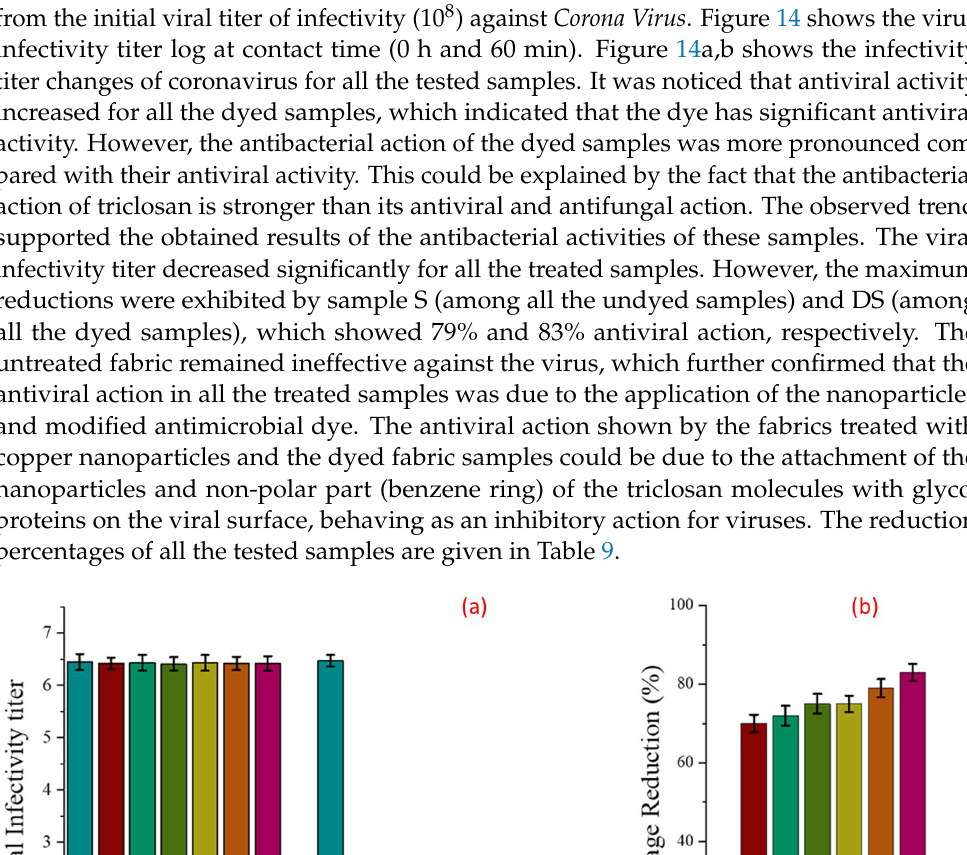
Table 9. Reduction percentages in antifungal activity.